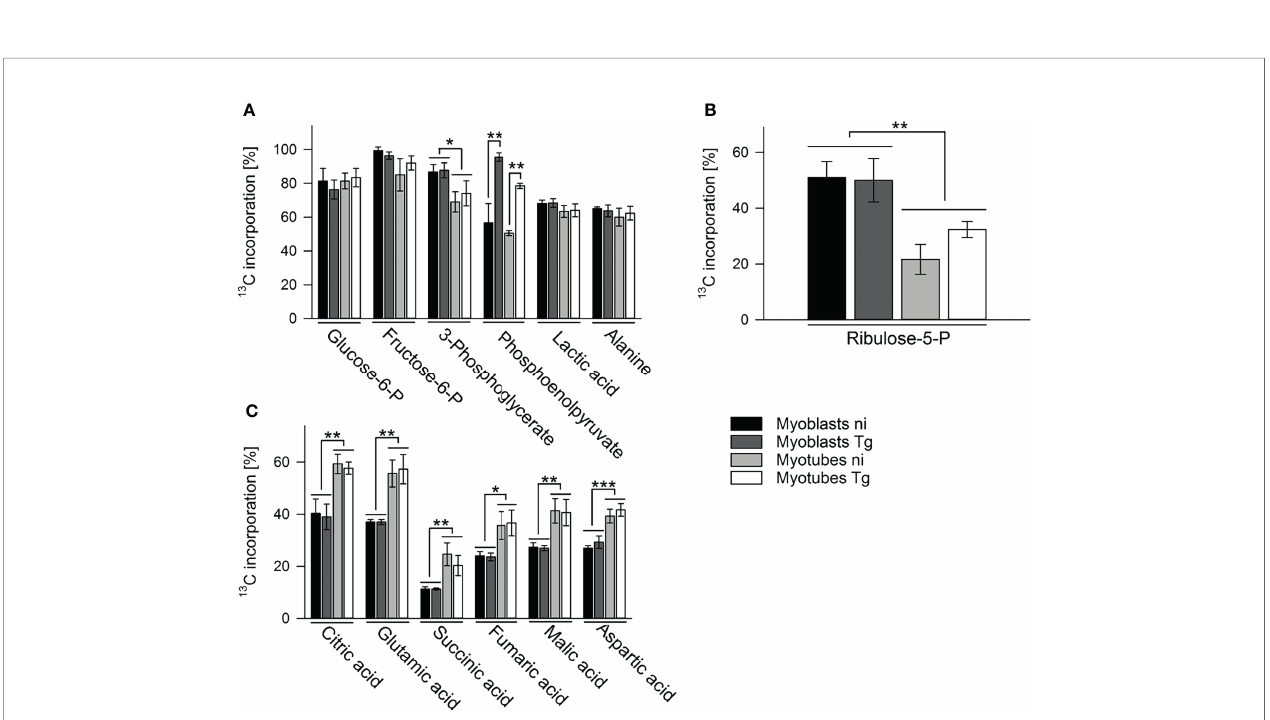
FIGURE 3 | Myoblasts and myotubes during infection with T. gondii differentially catabolize glucose in the PPP and the TCA cycle. C2C12 myoblasts and in vitro - differentiated myotubes were infected with T. gondii for 6 hours or were left non-infected and were then incubated in complete medium containing 13 C-U-glucose for 4 hours. 13 C enrichment into intermediates in glycolysis (A) , the oxPPP (B) and the TCA cycle (C) was determined by GC-MS. Data are means ± S.E.M. from three independent experiments; signi fi cant differences were identi fi ed by ANOVA (* p < 0.05; ** p < 0.01; *** p < 0.001).